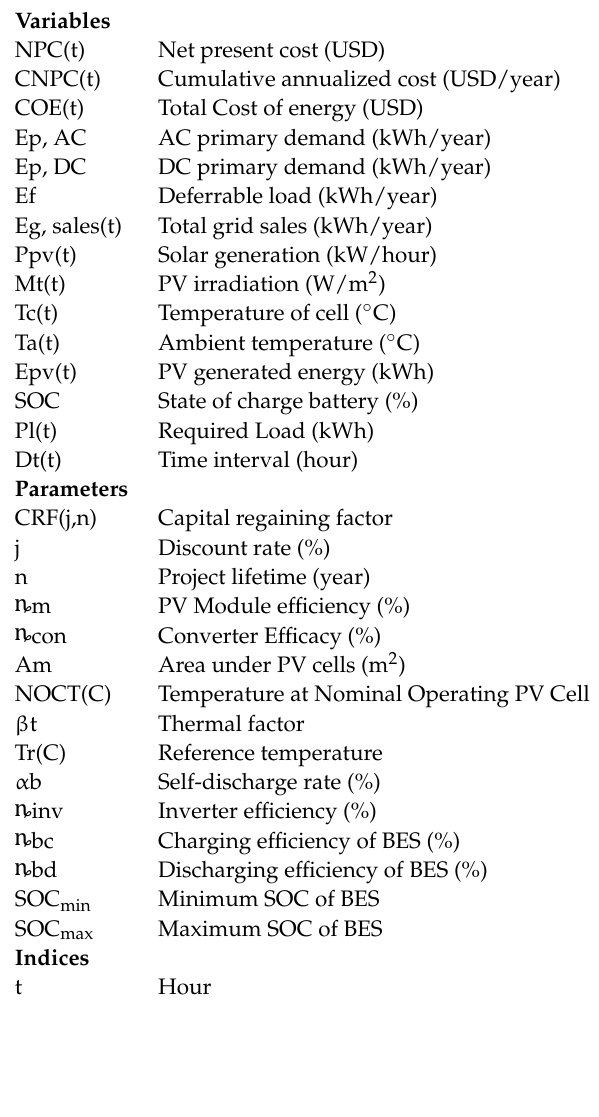
Table 1. The Electricity Tariffs in Indonesia [35].